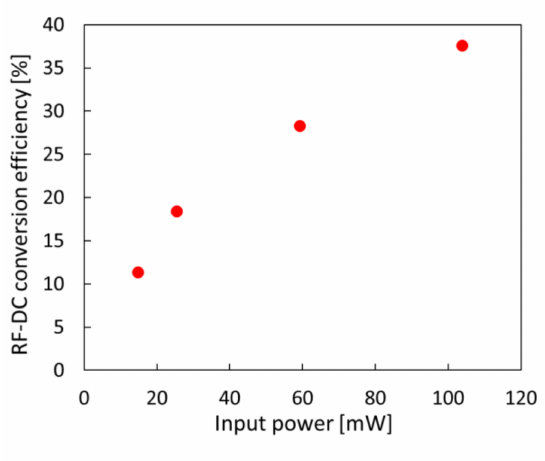
Figure 18. 94 GHz antenna ( a ) S11 ( b ) radiation pattern.